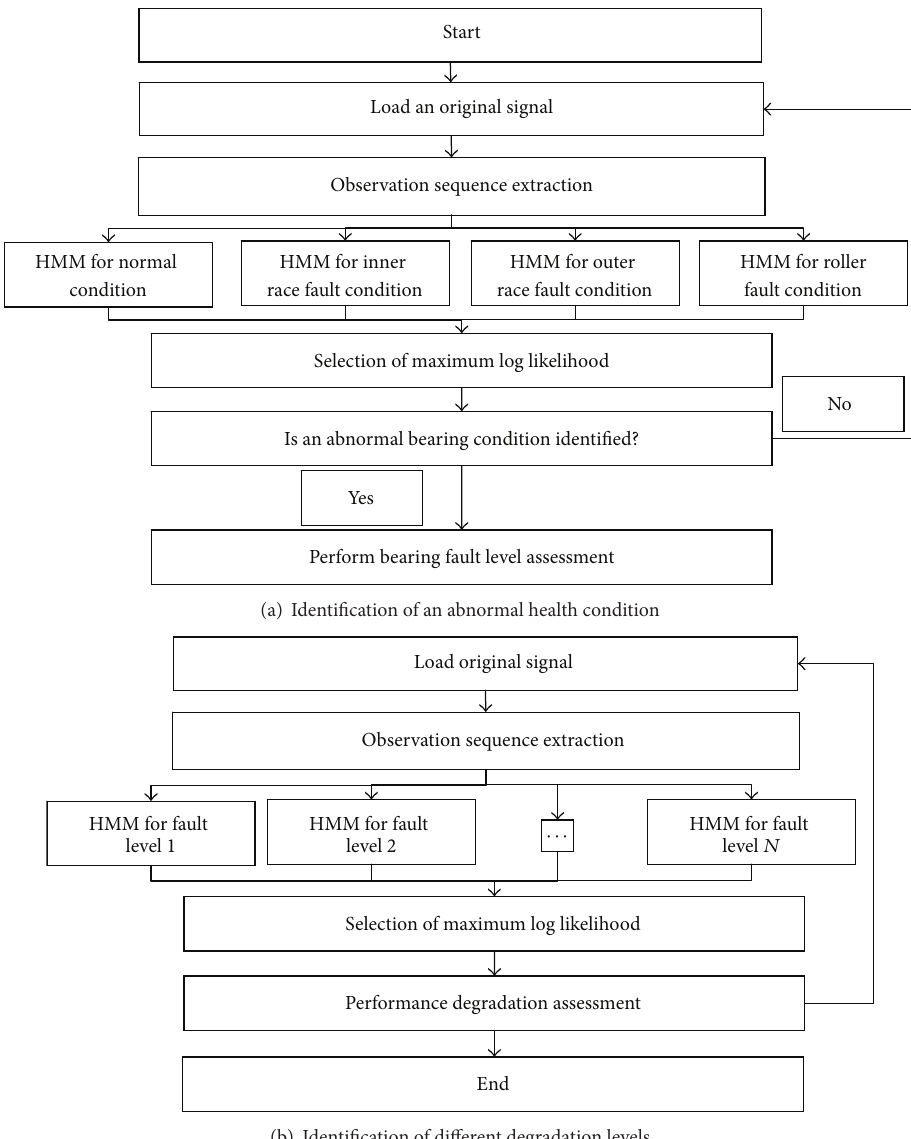
Figure 1: The presented flowchart for bearing performance degradation assessment in the case of available historical